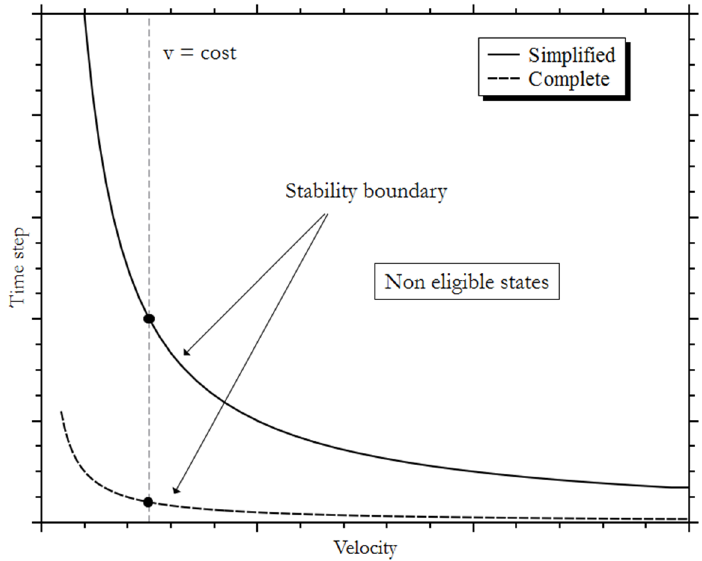
Figure 8. The stability condition curves for the two